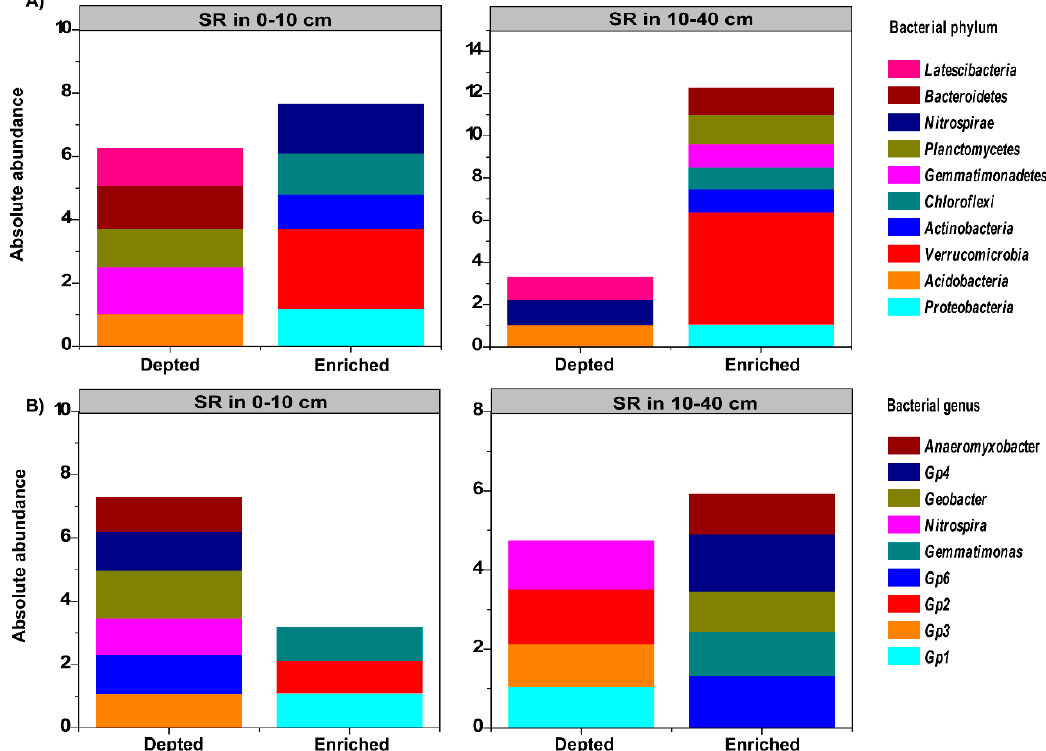
Figure 6. Sugarcane straw retention (SR) depleted or enriched of abundant phyla ( A ) and genera ( B ) at depths of 0–10 and 10–40 cm compared to the control (CK).